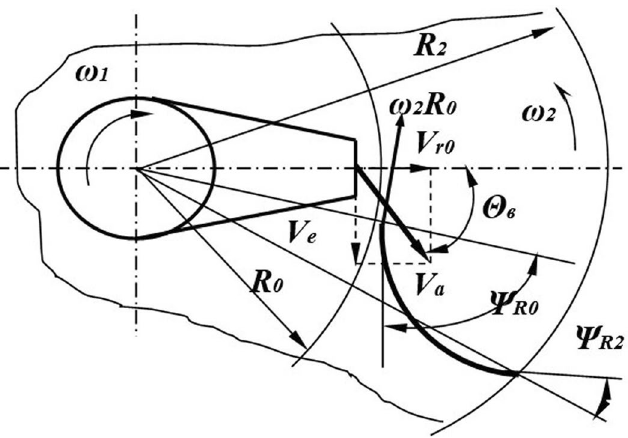
Figure 5. Determine the angle of the blade setting in the case of counterrotation. Source: author’s